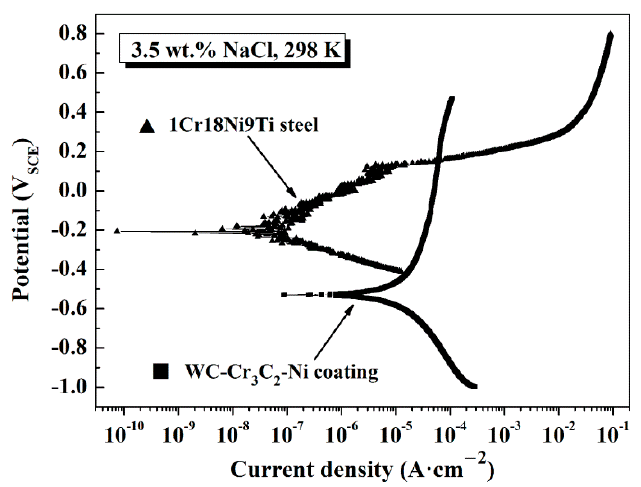
Figure 6. Potentiodynamic polarization curves of the WC-Cr 3 C 2 -Ni coating and the 1Cr18Ni9Ti stainless steel in 3.5 wt.% SCM.